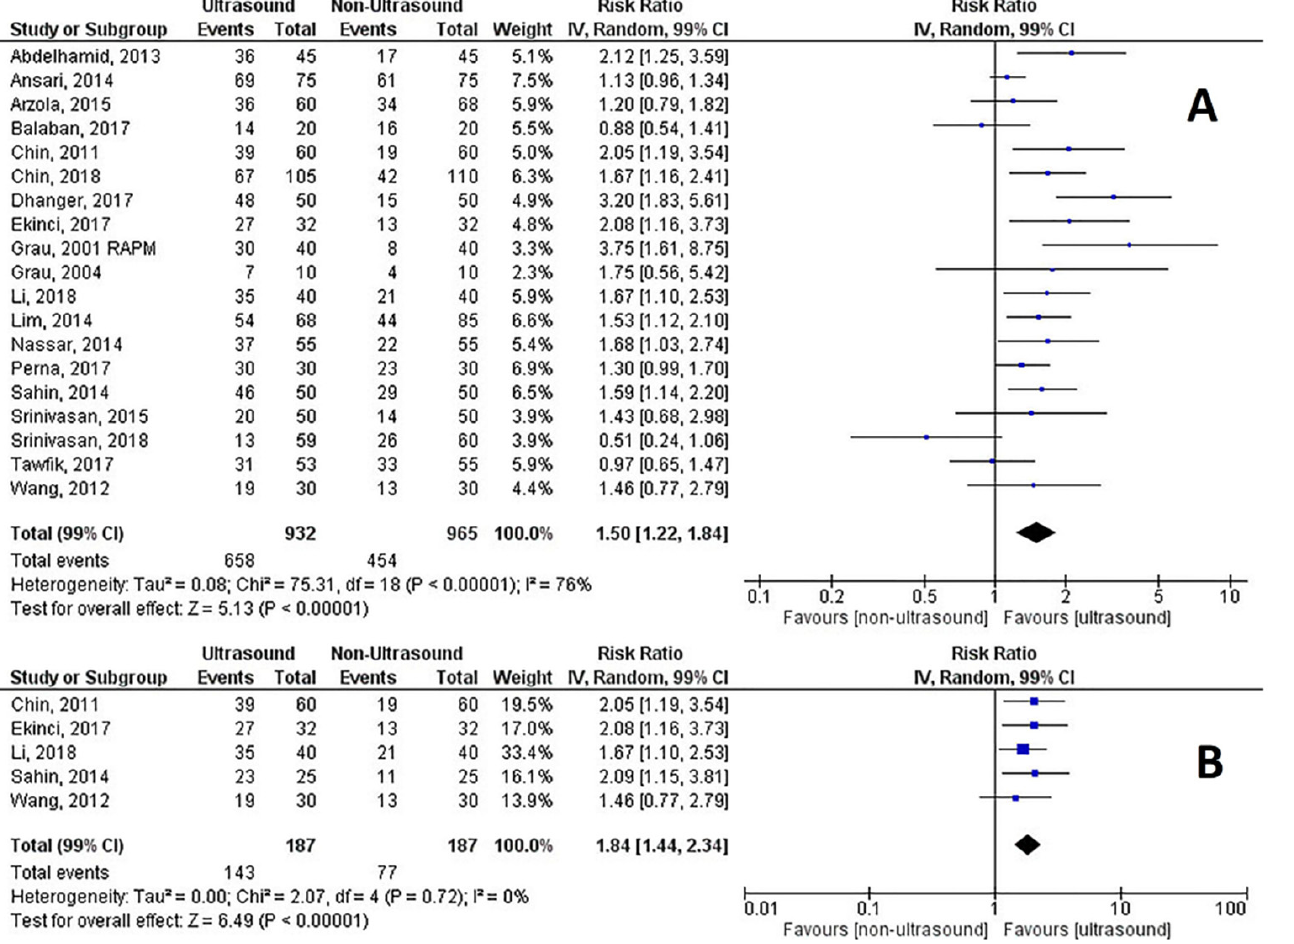
Figure 4. ( A ) First-attempt success rate of neuraxial procedures; ( B ) First-attempt success rate in difficult spines and obese patients.